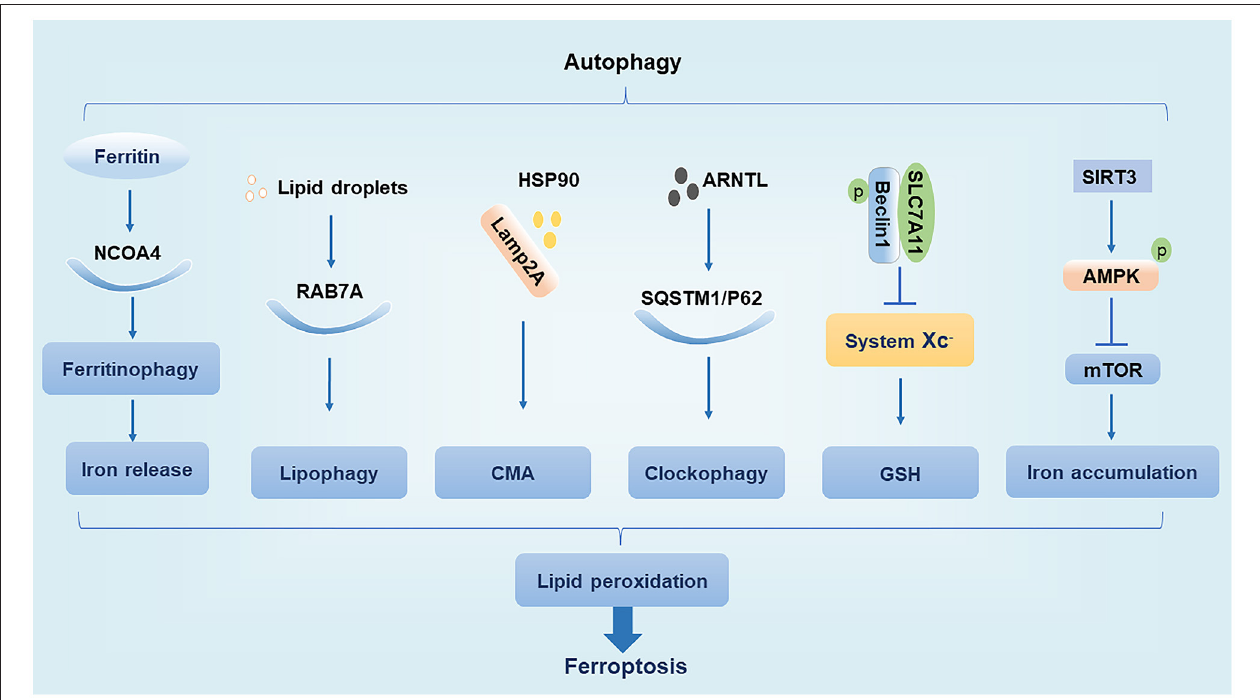
FIGURE 1 | Relationship between autophagy and ferroptosis. NCOA4, nuclear receptor coactivator 4; Lamp2A, lysosome associated membrane protein 2A; HSP90, heat shock protein 90; AMPK, AMP-activated protein